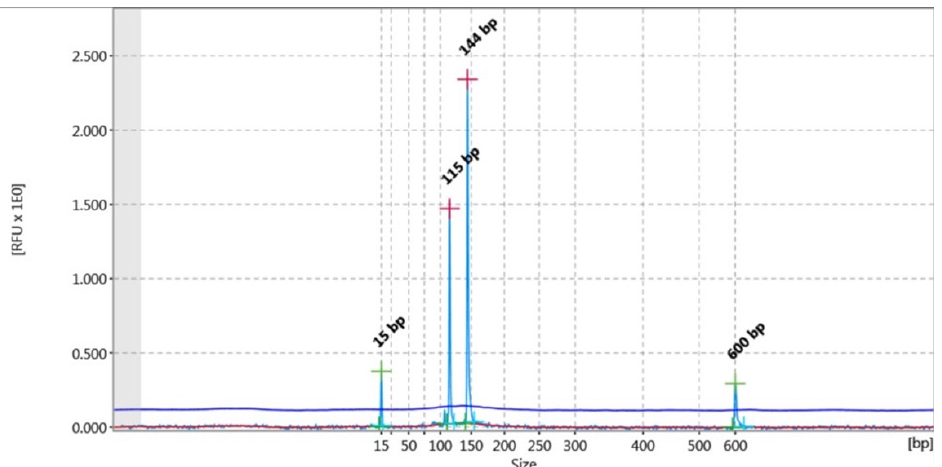
Figure 1. An XY brown bear: 2 bands appeared post capillary electrophoresis via QIAxcel (144 bp and 115 bp). The 15 bp and 600 bp peaks were derived from the QX DNA Size Marker that was used (see Supplementary Material). Table 1. Primer sequence and length of the 10 microsatellite loci.